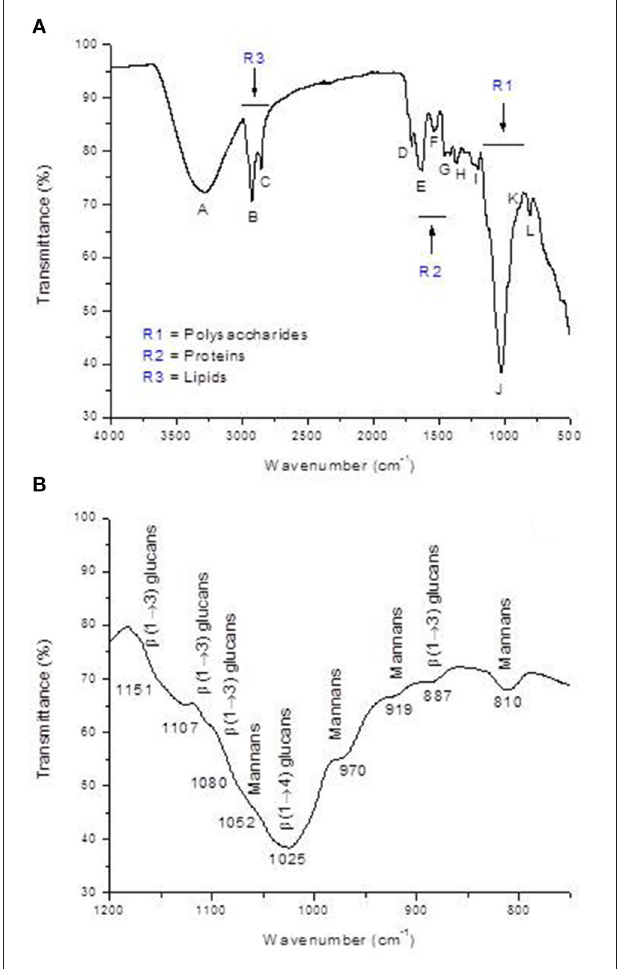
FIGURE 3 | (A) Representative FTIR spectrum of the yeast cell wall fraction (YCW), and (B) baseline corrected FTIR spectrum of the polysaccharide absorbing region (R1 = 1200-750 cm − 1 ).